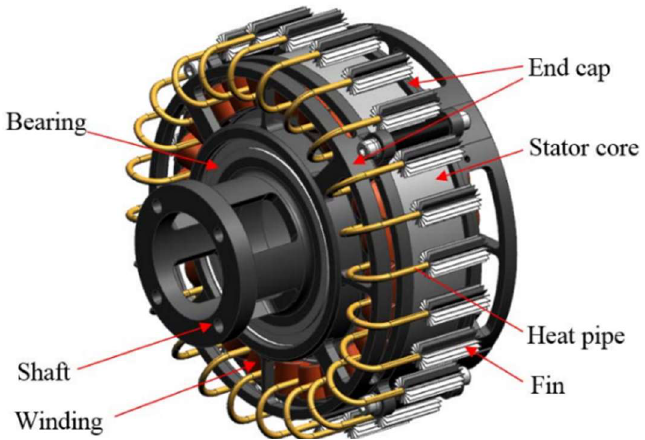
Figure 9. An electrical machine with U-shaped heat pipes [33].